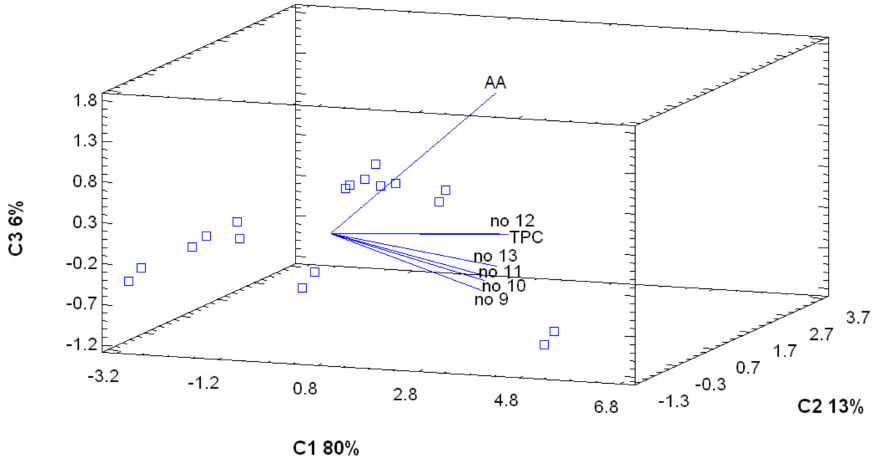
Figure 6. Principal components analysis of the tested parameters in